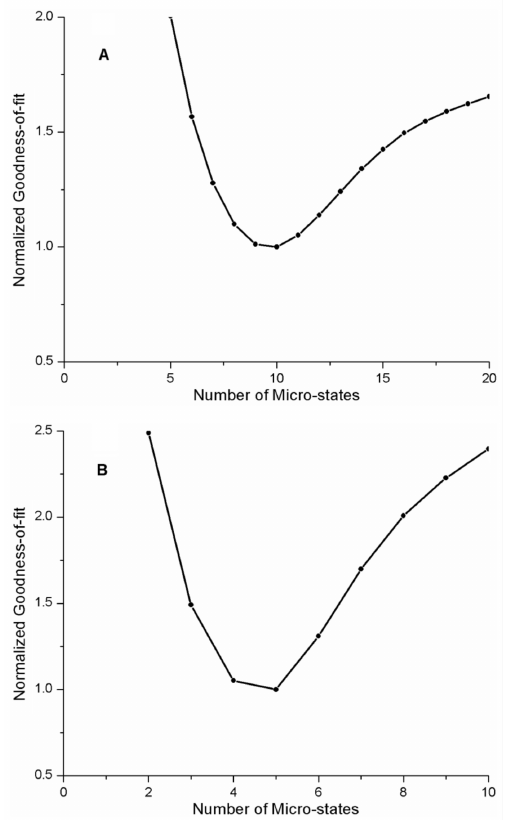
Figure 6. Goodness-of-fit as a function of number of microstates, N. ( A ) p38 α kinase-AG1478 complex. ( B ) APH2 aminoglycosidase-AG1478 complex.